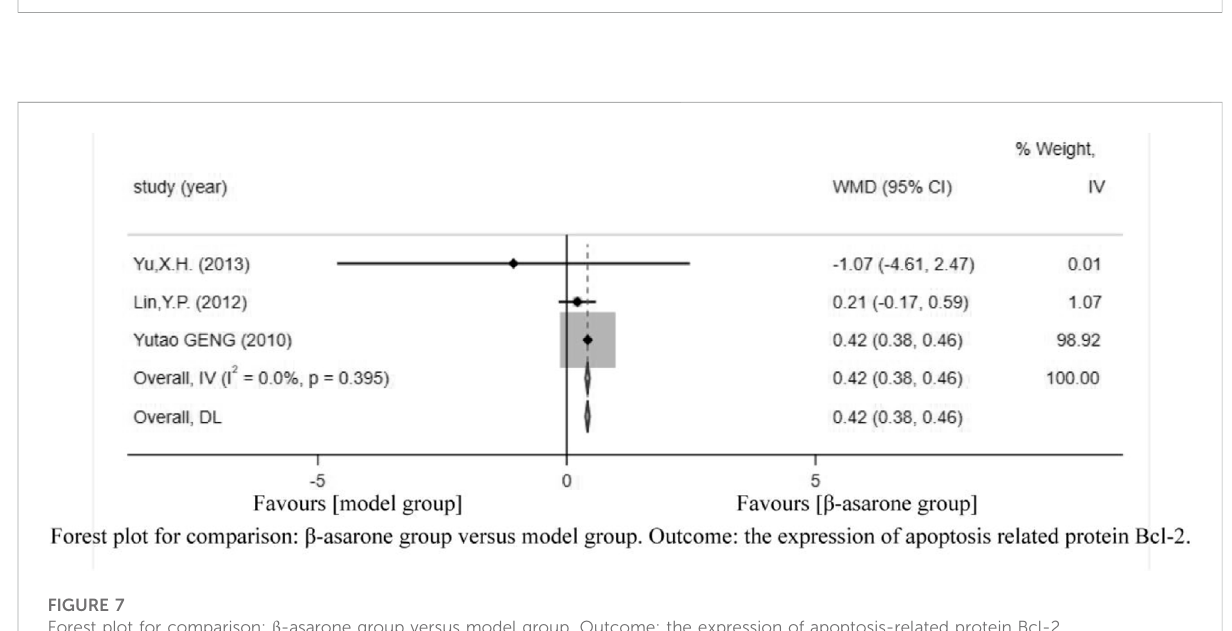
FIGURE 6 Forest plot for comparison: β -asarone group versus model group. Outcome: the expression of apoptosis-related protein Bax.